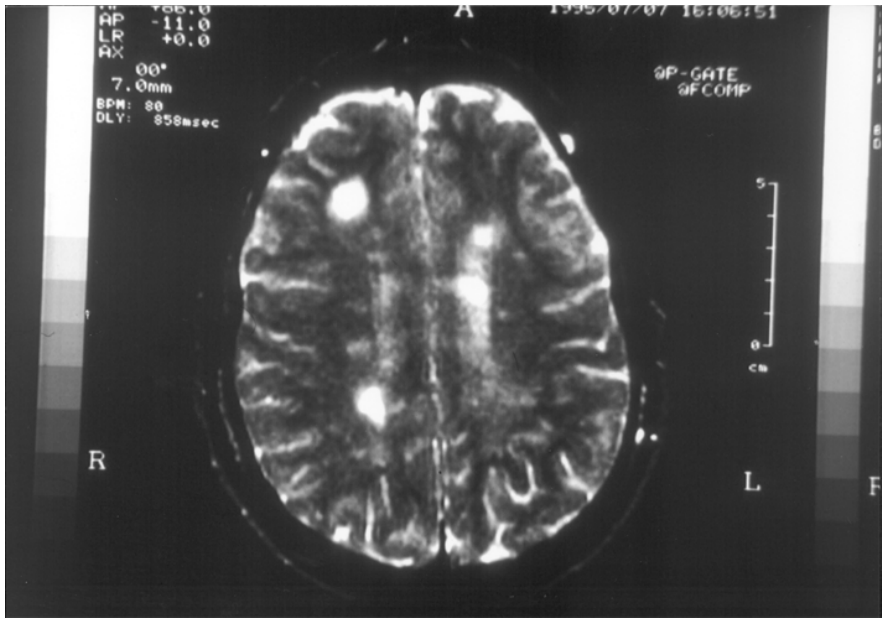
Fig. 2. T2-weighted Gadolinium-enhanced-MRI of the brain. Hypersignal lesions in periventricular white matter and a large lesion in the right frontal